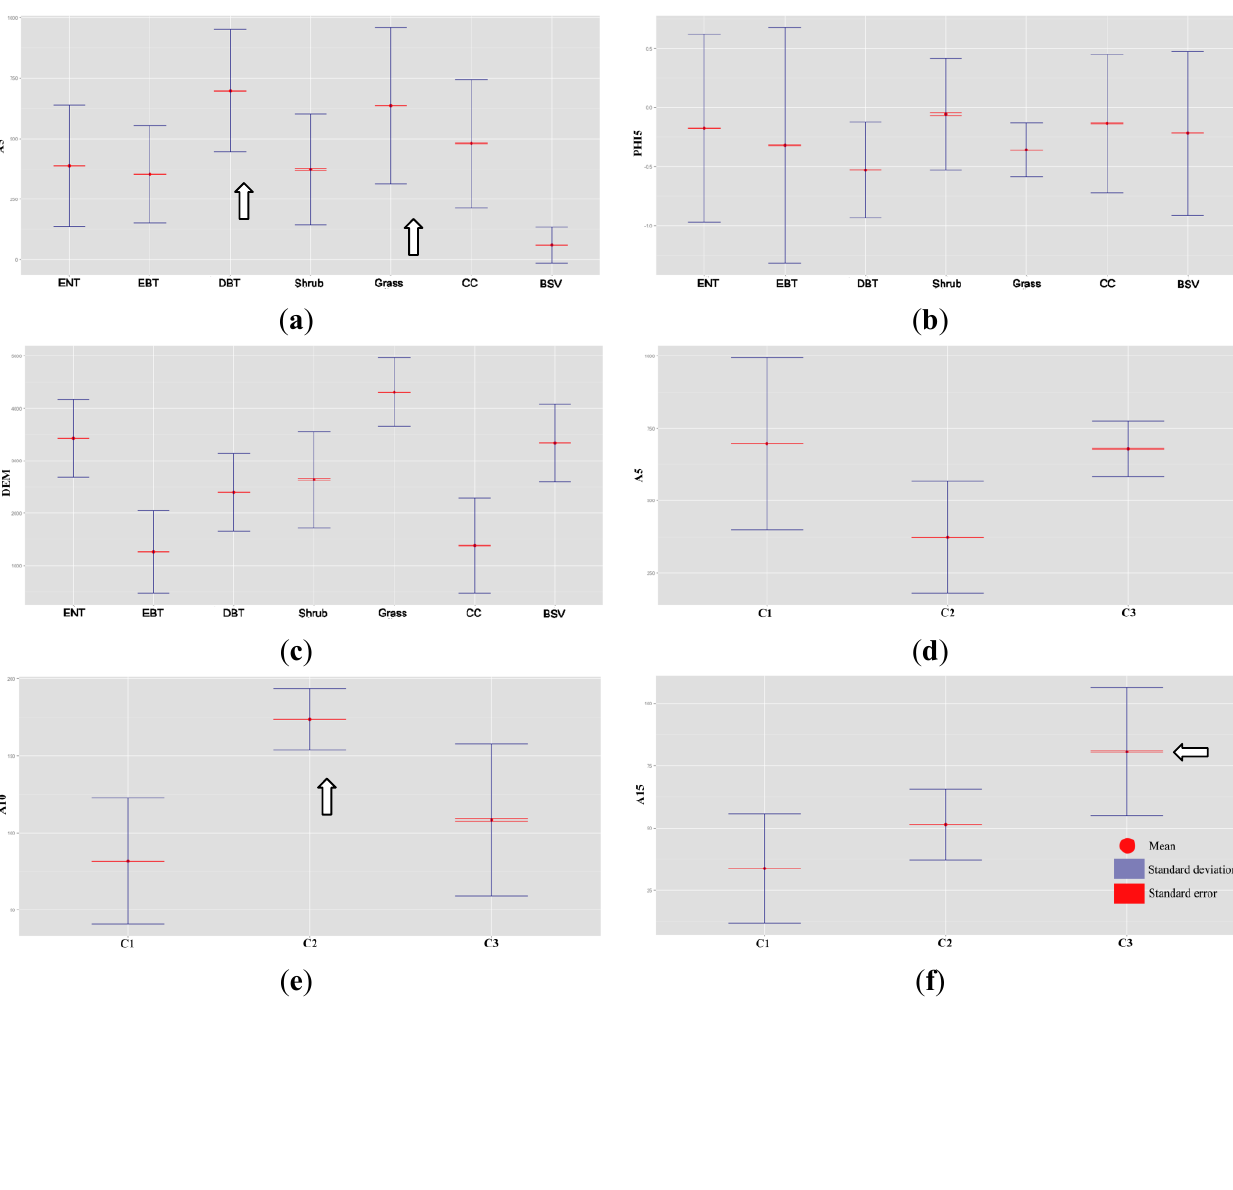
Figure 3. Mean and standard deviation of each PFT in ( a ) amplitude A